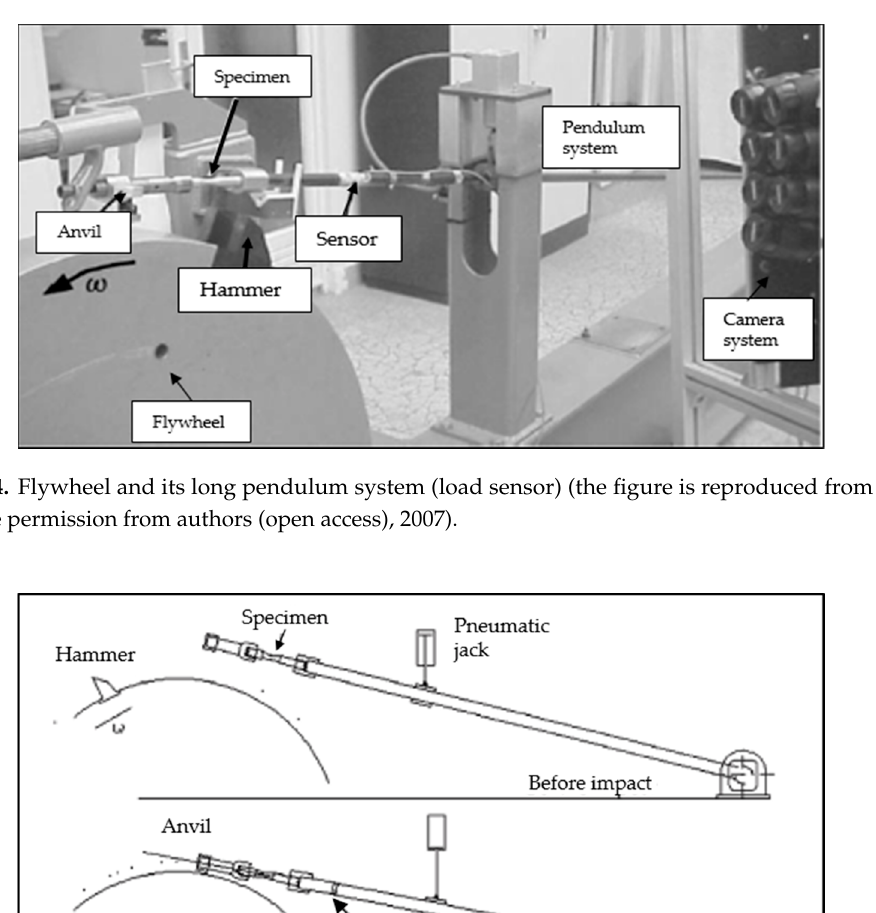
7 of 24 Figure 3. ( a ) Overall view of Dropkinson bar test and ( b ) illustration of specimen displacement measurements (the figure is reproduced from [42], with the permission from authors & EPJ Web of Conferences (open access), 2018). The loading mechanism of the Dropkinson bar combines a drop table and a Hopkinson bar; it generates stable and durable impact velocity and facilitates deformation in the specimen at a constant strain rate. A long Hopkinson bar system was used to measure the load history to reduce the effect of inertia in the system. The Hopkinson bar is fixed parallel to the drop table. The drop table is used to generate a free fall impact of the trolley, as shown in Figure 3. A cylindrical steel impactor attached to the bottom of a carriage strikes the center of the impact plate during the test. The guided rods are situated in the impact plate to ensure uniaxial travel of the drop table. A plastic bumper is installed on the bottom of the impact plate to absorb the momentum. One end of the specimen is fixed to the impact plate adapter, and the other to the Hopkinson bar, as shown in Figure 3. Two strain gauges are attached to the bar to measure the load history. After the free fall of the carriage, the impactor attached to the bottom of the carriage hits the impact plate at the center. The impact plate transfers the impact load to the tensile specimen in dynamic tension. The tensile stress wave transmits into the vertical bar through the specimen and bar end. The strain gauges attached to the bar, record the load history of the specimen. Furthermore, a custom laser extensometer is used to calculate the specimen strain. The strain rate obtained using the Dropkinson bar is up to 600 s –1 with a loading time of 0.5 ms, producing a strain of 0.27. A newly developed Dropkinson bar has shown reliable results. However, there is a significant amount of ringing noise; it may alter the force and strain signals due to the impact between the impactor and the moving metallic carriage. 2.4. Flywheel Device The flywheel device is a dynamic testing apparatus designed by researchers to perform the test at intermediate and higher strain rates. In this rotary type of testing machine, the kinetic energy of the rotating flywheel is used to fracture specimens at different strain rates. The loading speed (mean strain rate) depends on the speed of the flywheel. The machine uses the kinetic energy stored in the flywheel to deform the specimen rapidly. Manjoine et al. [64] and Quinlan et al. [65] carried out dynamic tensile tests on various metallic materials using a flywheel device at strain rates up to 1000 s –1 . Load and deformation were measured using optical technologies, incorporating a piezoelectric load sensor. This apparatus is designed to perform tests at elevated temperatures. A new flywheel tensile testing device was developed at the Institute of Mechanics and Engineering, Bordeaux, derived from the Charpy pendulum system; its